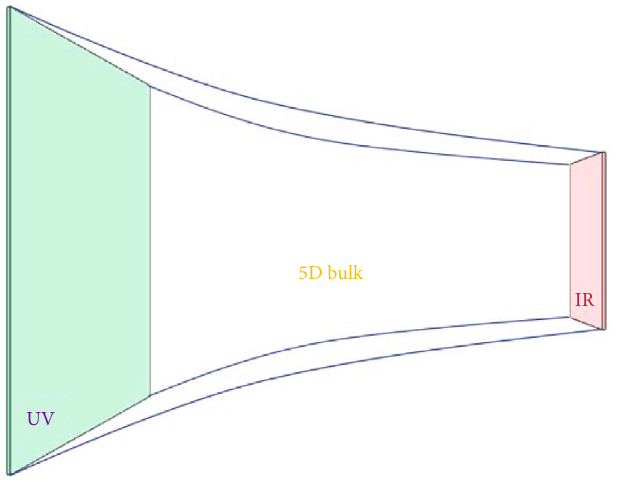
Figure 4: Schematic view of the RS geometry. The warp factor decreases exponentially along the